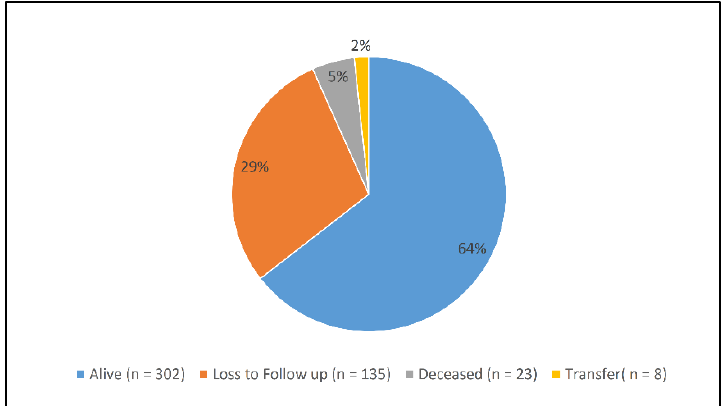
Figure 1. Status of patients at enrollment.